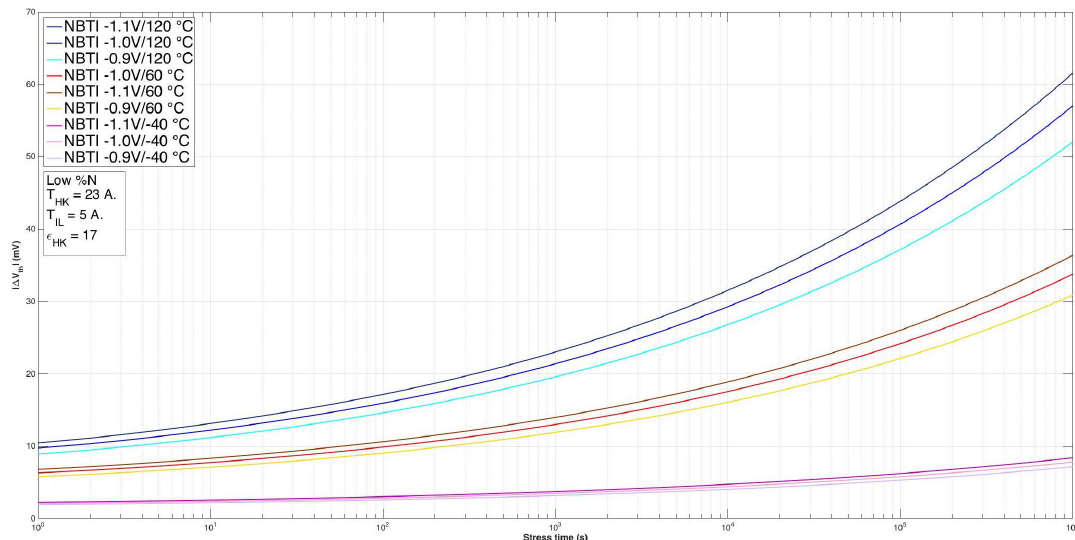
Figure 9. Low nitrogen concentration with respect to NBTI evaluation under different temperatures and bias conditions.